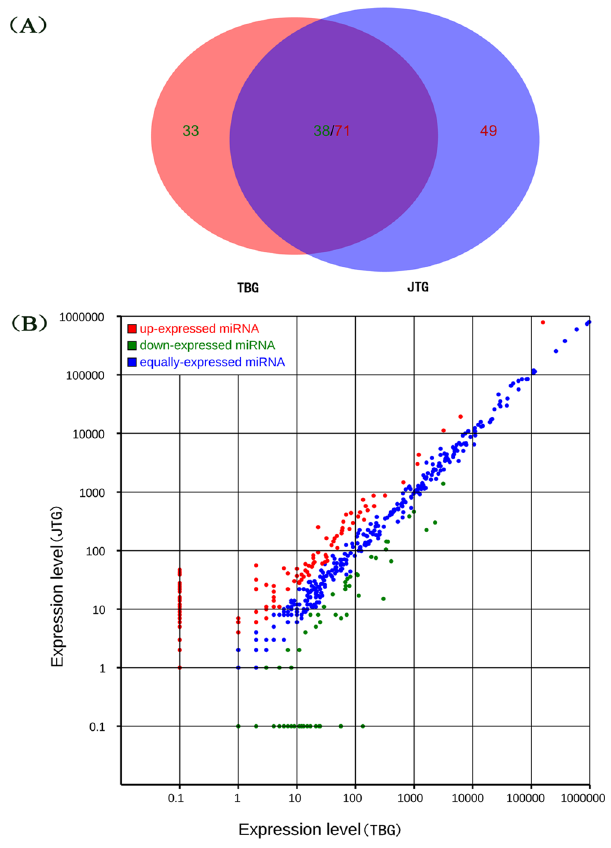
Figure 3. Differentially expressed miRNAs between the non-prolific Tibetan goat (TBG) and prolific Jintang black goat (JTG) ovary libraries. ( A ) Venn diagram displaying the distribution of 191 differentially expressed unique miRNAs (fold-change ≥ 1.0 or ≤ − 1.0 and q - value < 0.05) in the non-prolific TBG (left circle) and prolific JTG libraries (right circle). The overlapping region indicates co-expressed unique miRNAs. ( B ) In the scatter plot of differentially expressed miRNAs, the red points indicate miRNAs with ratios > 2; the blue points indicate miRNAs with 1/2 < ratios ≤ 2; and the green points indicate miRNAs with ratios ≤ 1/2. Ratio = normalized expression of JTGs/normalized expression of TBGs.